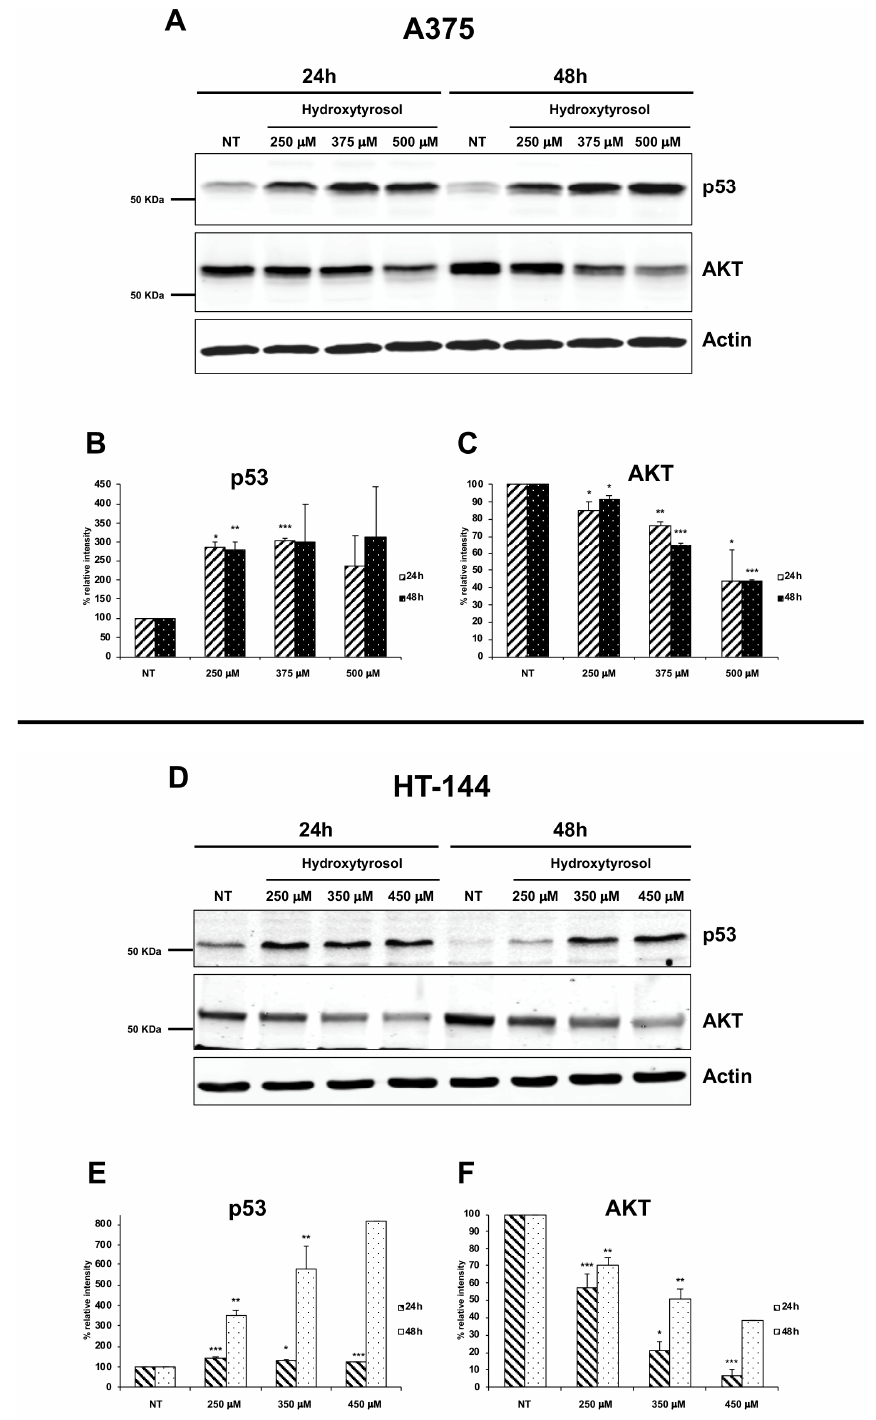
Figure 5. Expression of p53 and AKT proteins in hydroxytyrosol treated melanoma cells. A375 cells ( A – C ) were treated with 250 µ M, 357 µ M, and 500 µ M of hydroxytyrosol and HT-144 cells ( D – F ) were treated with 250 µ M, 350 µ M, and 450 µ M of hydroxytyrosol for 24 h and 48 h. The expression of p53, ( A , D , upper panels, B , E ) and AKT signalling proteins, ( A , D , middle panels, C , F ), was analysed in A375 and HT-144 cell lines in response to the treatment with hydroxytyrosol through western blot experiments. The equal protein loading was confirmed by the analysis of β -actin expression, ( A , D , lower panels). The data are representative of several western blot experiments. The error bars indicate the standard deviation. Statistical significance was analysed by Student’s t -test: * p < 0.05 was considered significant; ** p < 0.01 highly significant; *** p < 0.001 very highly